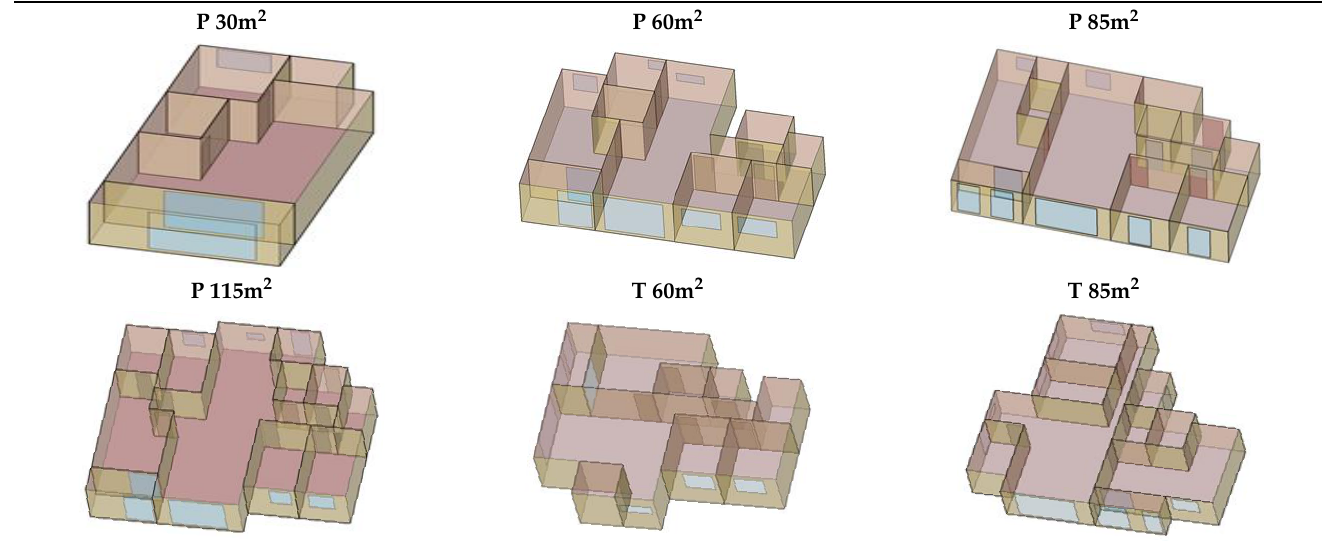
Table 1. Analysis target unit residential type and EnergyPlus modeling (P: Plate type, T: Tower type). P 30 m 2